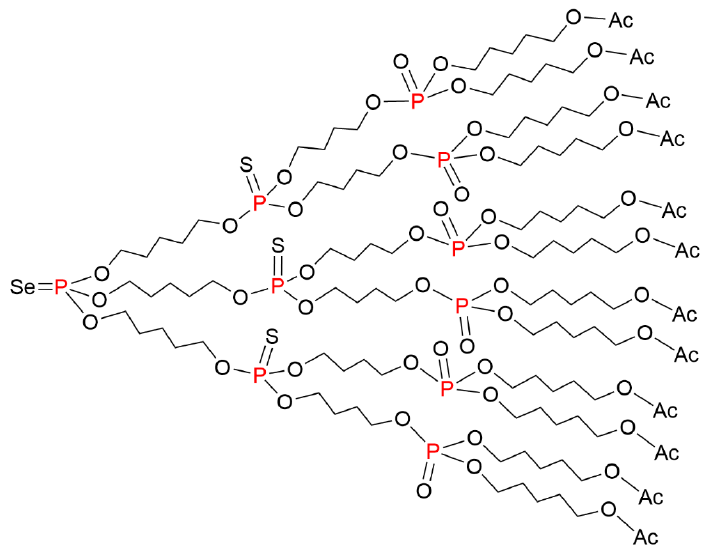
Figure 5. Layered dendrimers bearing three different types of branching units (P=Se, P=S, P=O).